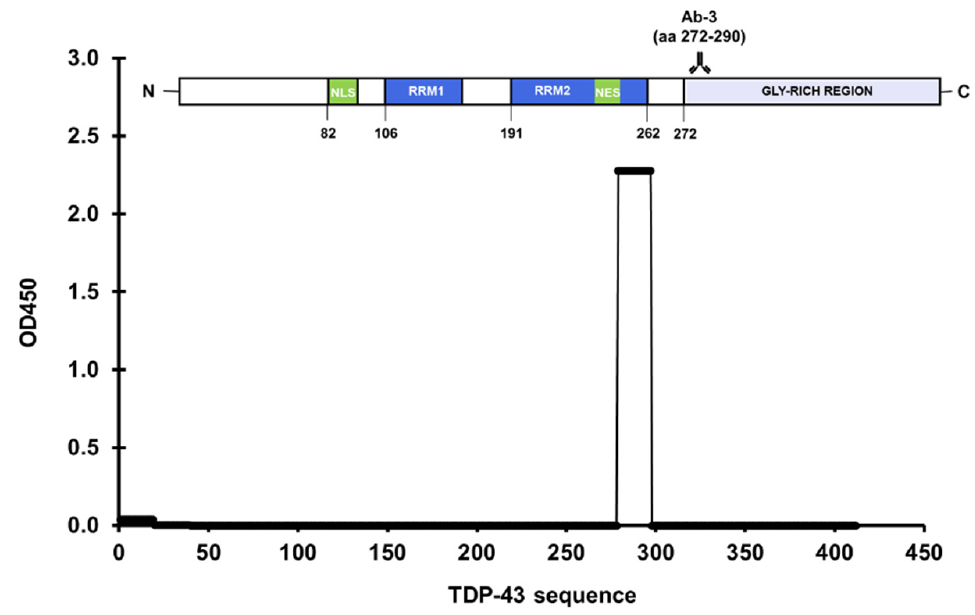
Figure 6. A significant absorbance was observed in aa 272–290 for polyclonal anti-TDP-43 antibody (12892-1-AP).